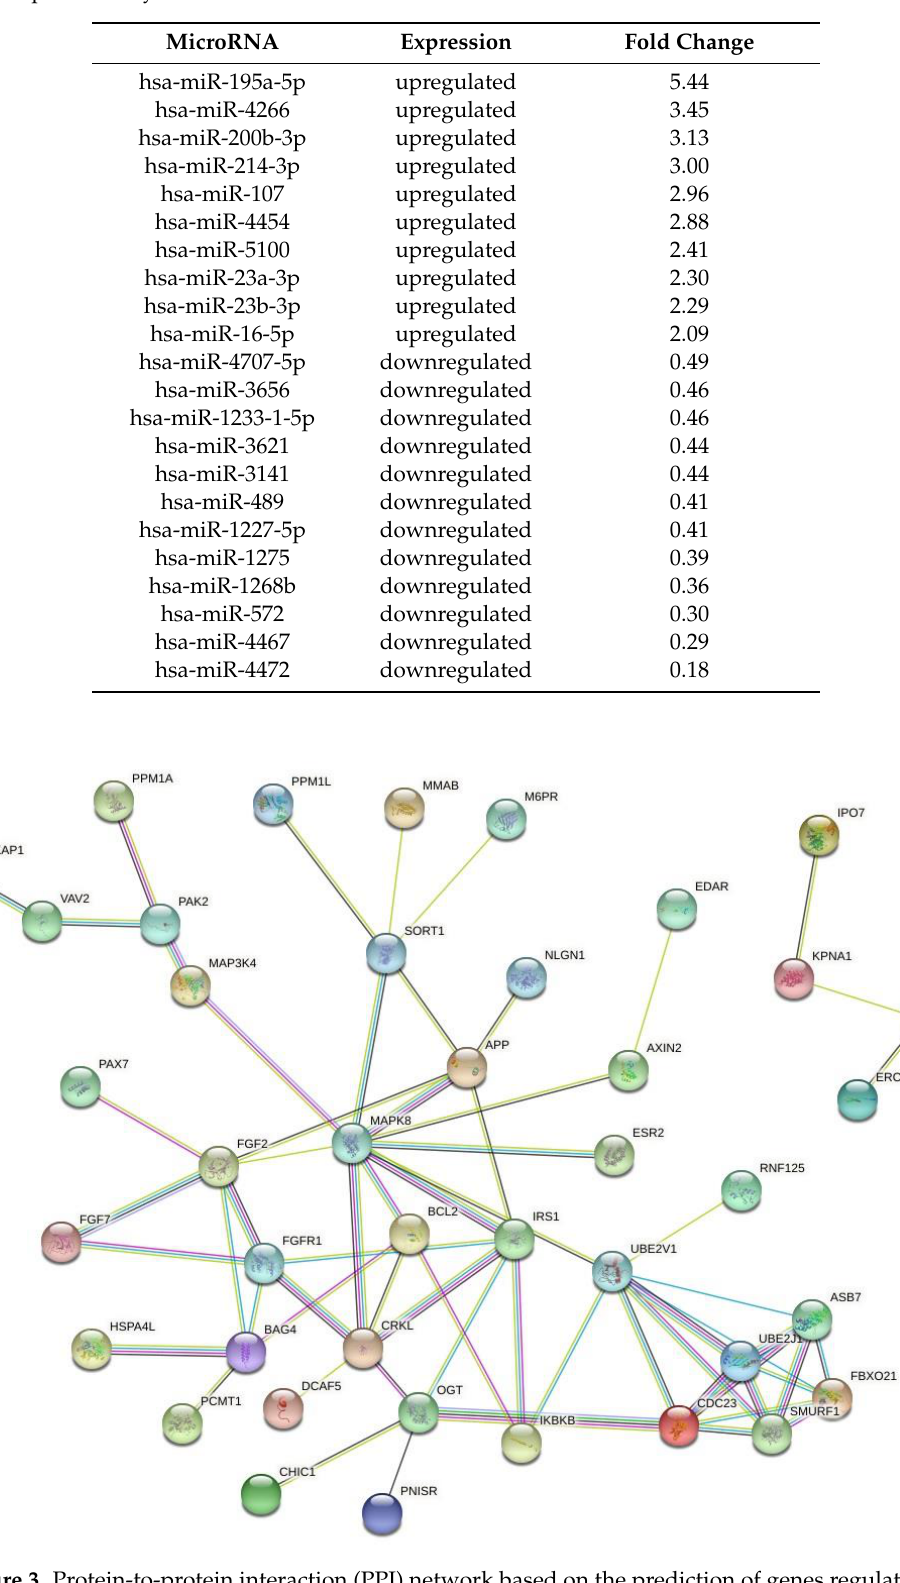
Figure 3. Protein-to-protein interaction (PPI) network based on the prediction of genes regulated by hsa-miR-195a-5p. Since this microRNA was associated with cancer chemoresistance, these genes may represent important drug targets. Figure generated with the online tool STRING (https://string-